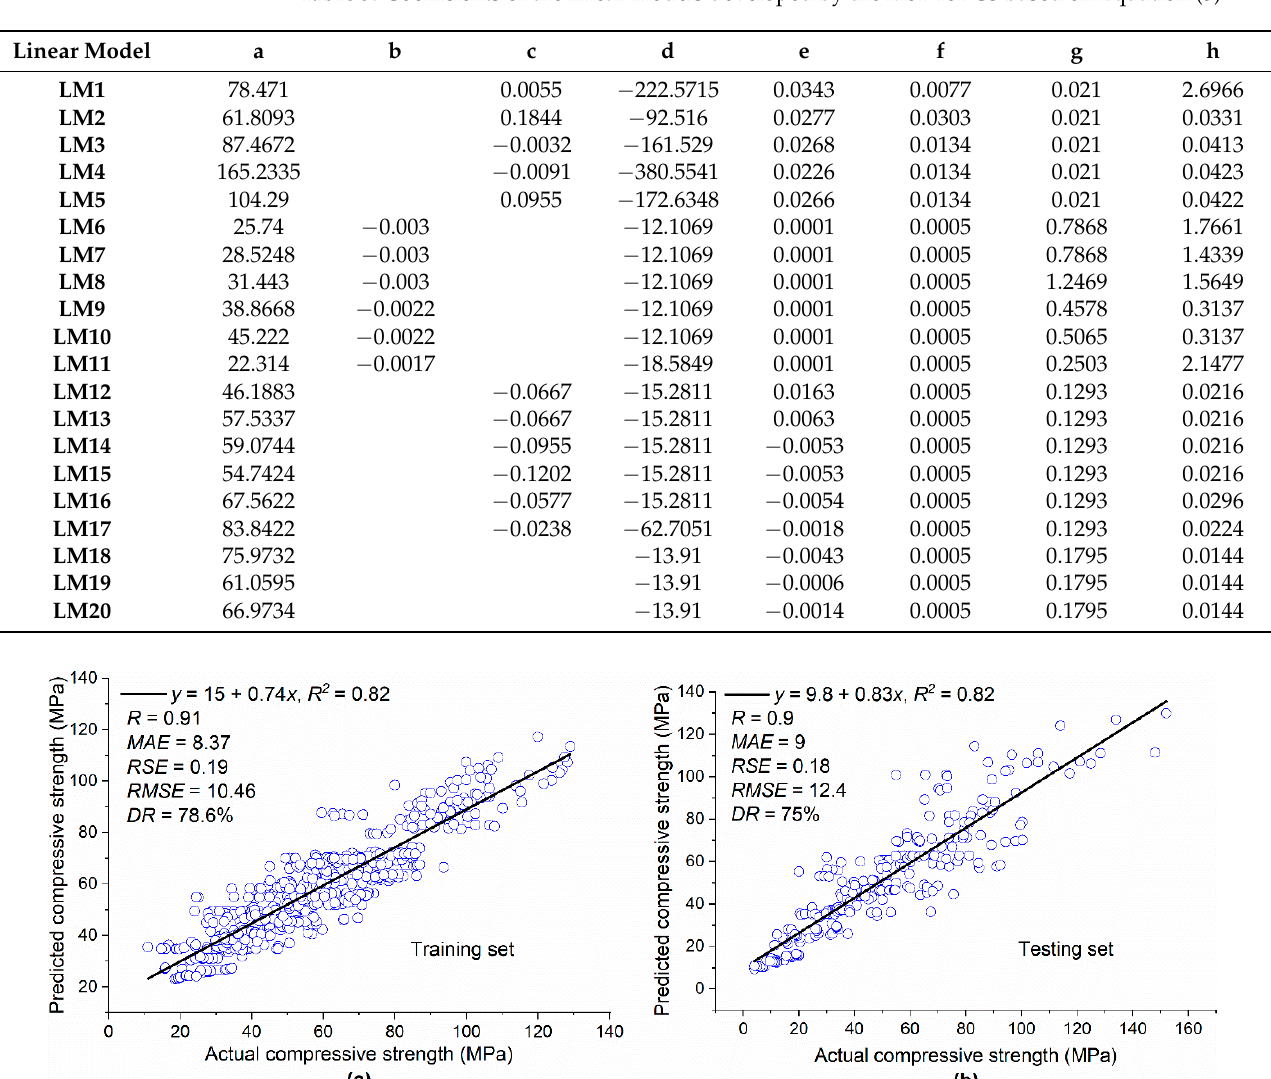
Table 3. Coefficients of the linear models developed by the M5P for CS based on Equation (3).